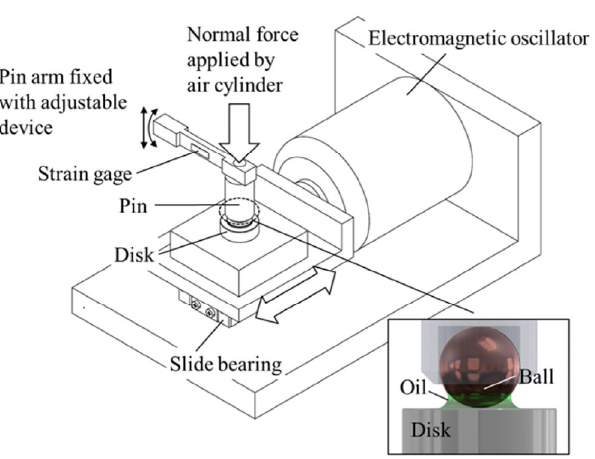
Fig. 2 Schematic of reciprocating